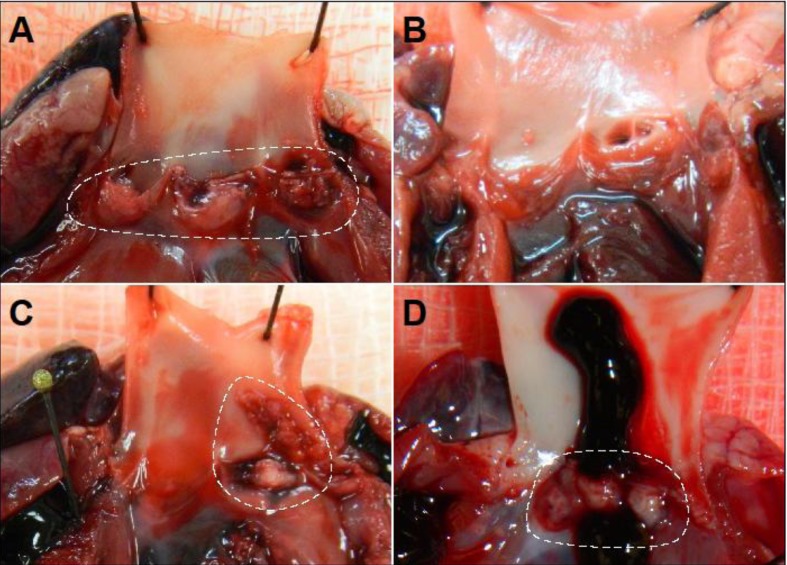
Deletion of the egc and tstH from MN8 leads to decreased vegetation formation.Representative images of vegetative lesions from (A) MN8 wild-type, (B) MN8ΔtstHΔegc, (C) MN8Δtst, and (D) MN8Δegc.